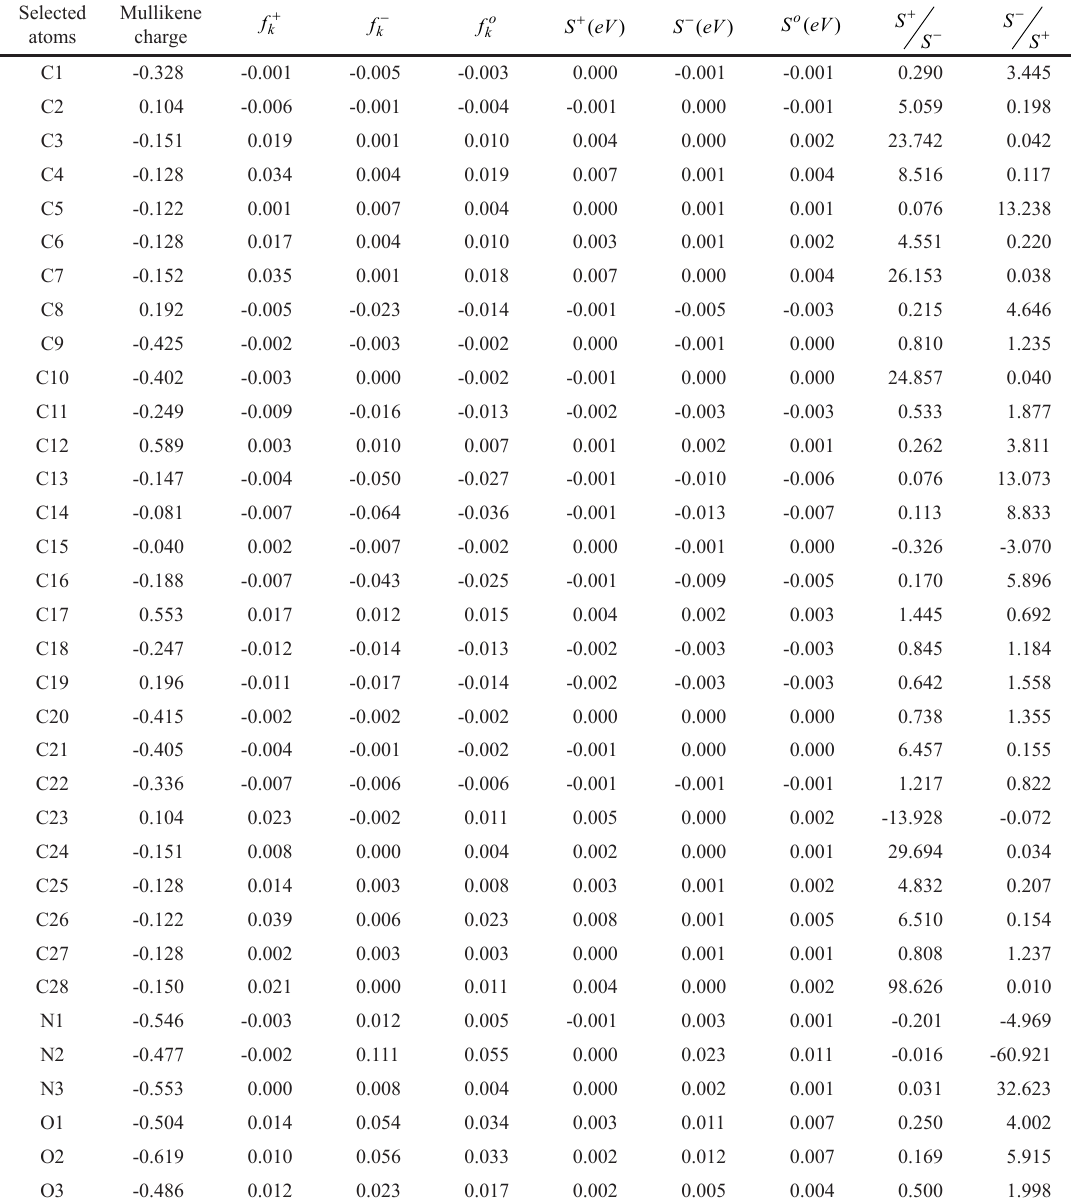
Table 7. The Mulliken population analysis of the condensed Fukui functions and local softness parameters on the selected atoms of oxetacaine . Selected Mullikene atoms